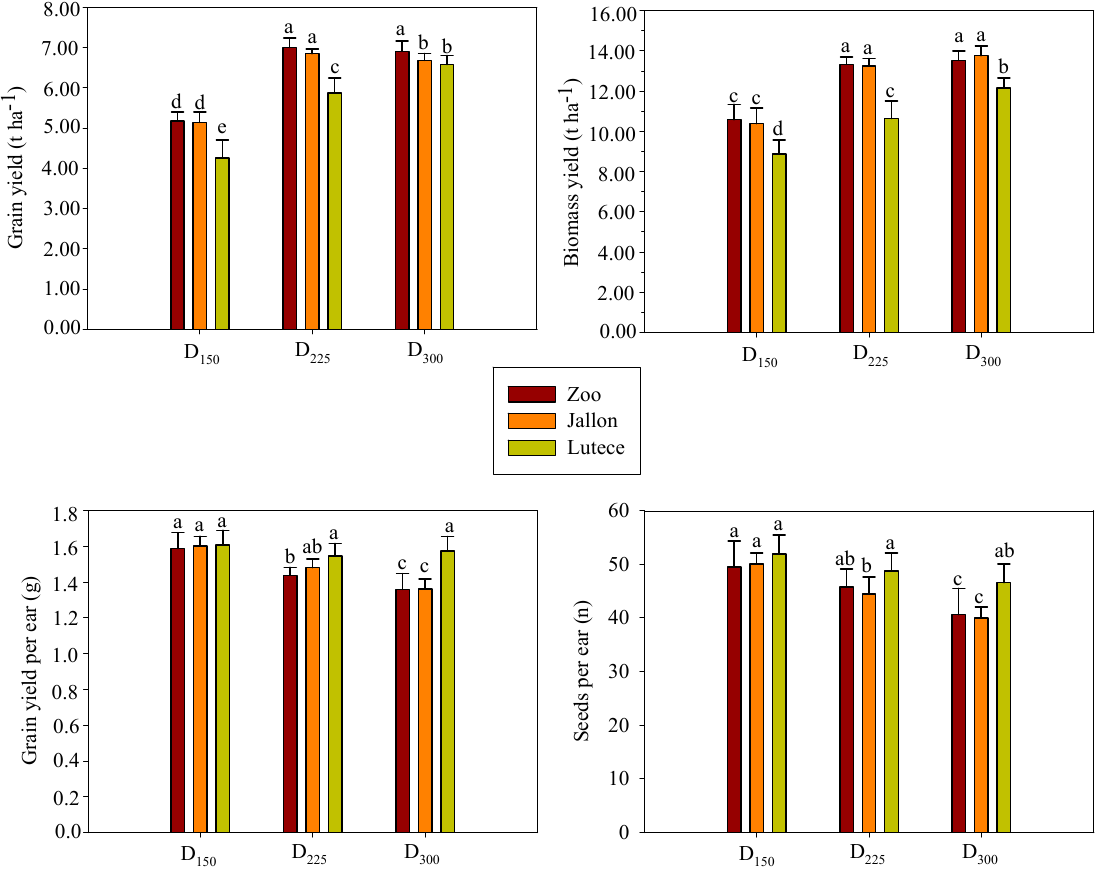
Figure 3. Grain yield, biomass yield, production per ear, and number of seeds per ear depending on seeding density (D) and variety (mean ± SD, n = 12). Within each graph, bars marked with different letters are statistically different ( p ≤ 0.05) according to Tukey’s HSD Test.